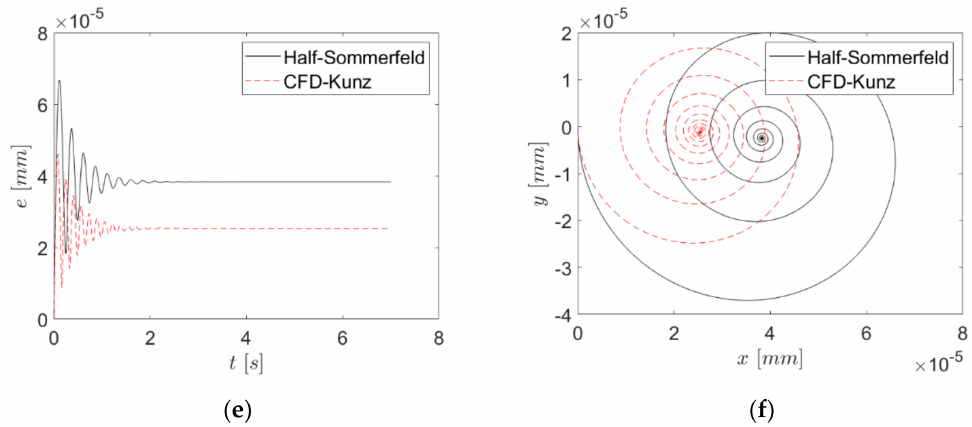
Figure 8. Trajectory of the journal ( b , d , f ) and damping ( a – c ) @328 rad / s for di ff erent masses: top